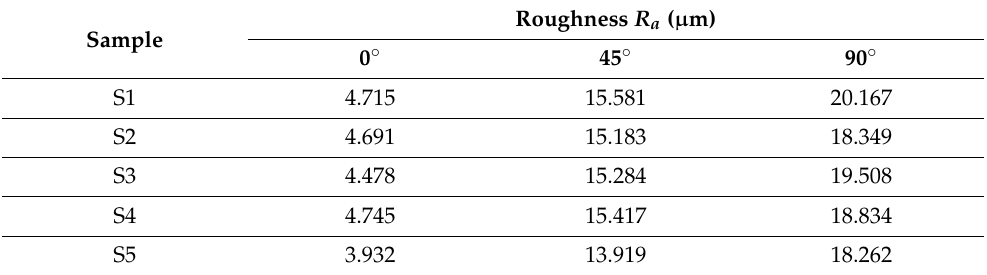
Figure 4. Roughness measurement strategy. Table 3. Surface roughness values before laser polishing. Table 3. Surface roughness values before laser polishing.